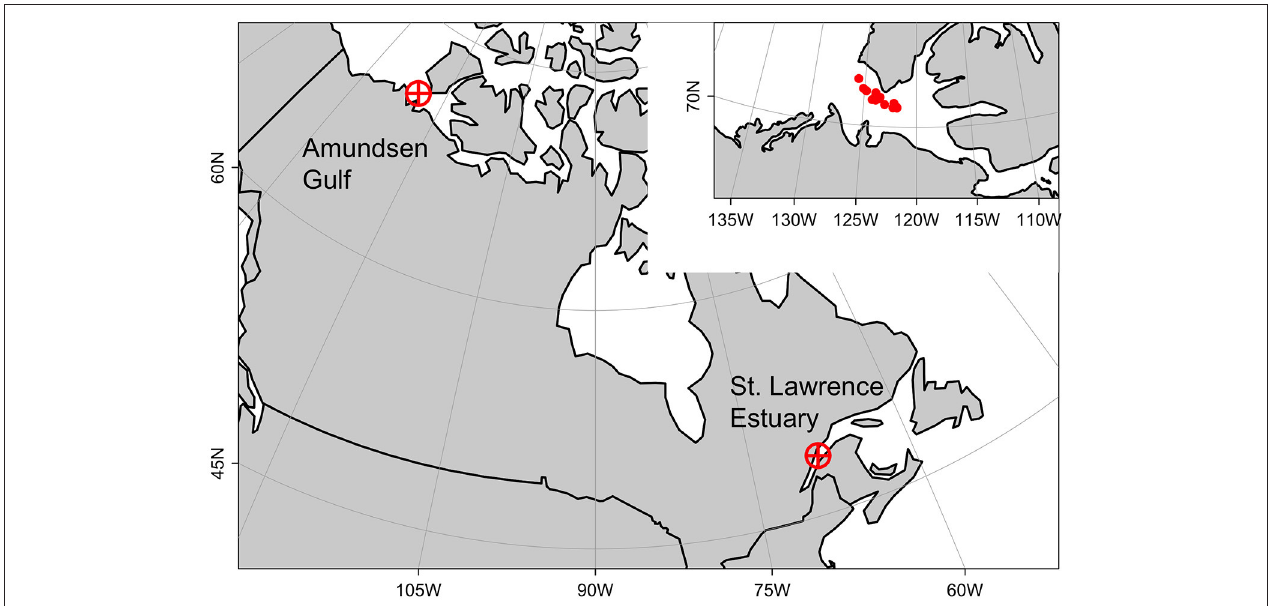
FIGURE 1 | Studied area. Arctic copepod species used in incubation experiments were sampled from the St. Lawrence Estuary. Environmental and biological forcing used in numerical experiments came from the Amundsen Gulf. Position of mean individual profiles shown in inset, upper-right corner.